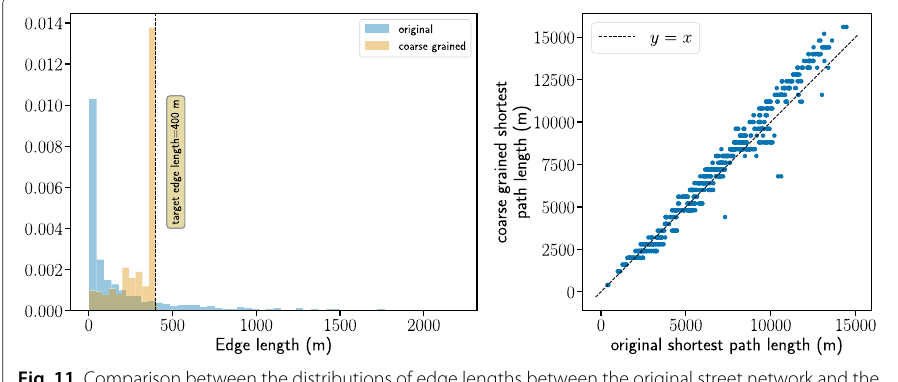
Fig. 11 Comparison between the distributions of edge lengths between the original street network and the coarse grained one, for Berlin. Coarge grainined network was created by merging all nodes with pairwise distance < 100 m, then intermediate nodes added to achieve a target edge length of 400 m. a The coarse grained network has a much narrower spread of edge lengths centered at 400 m, as expected. b Original weighted shortest path lengths in meters vs. unweigthed shortest path lengths in the coarse grained network, multiplied by the average link length in meters. All points lie close to the diagonal, indicating that shortest path lengths are